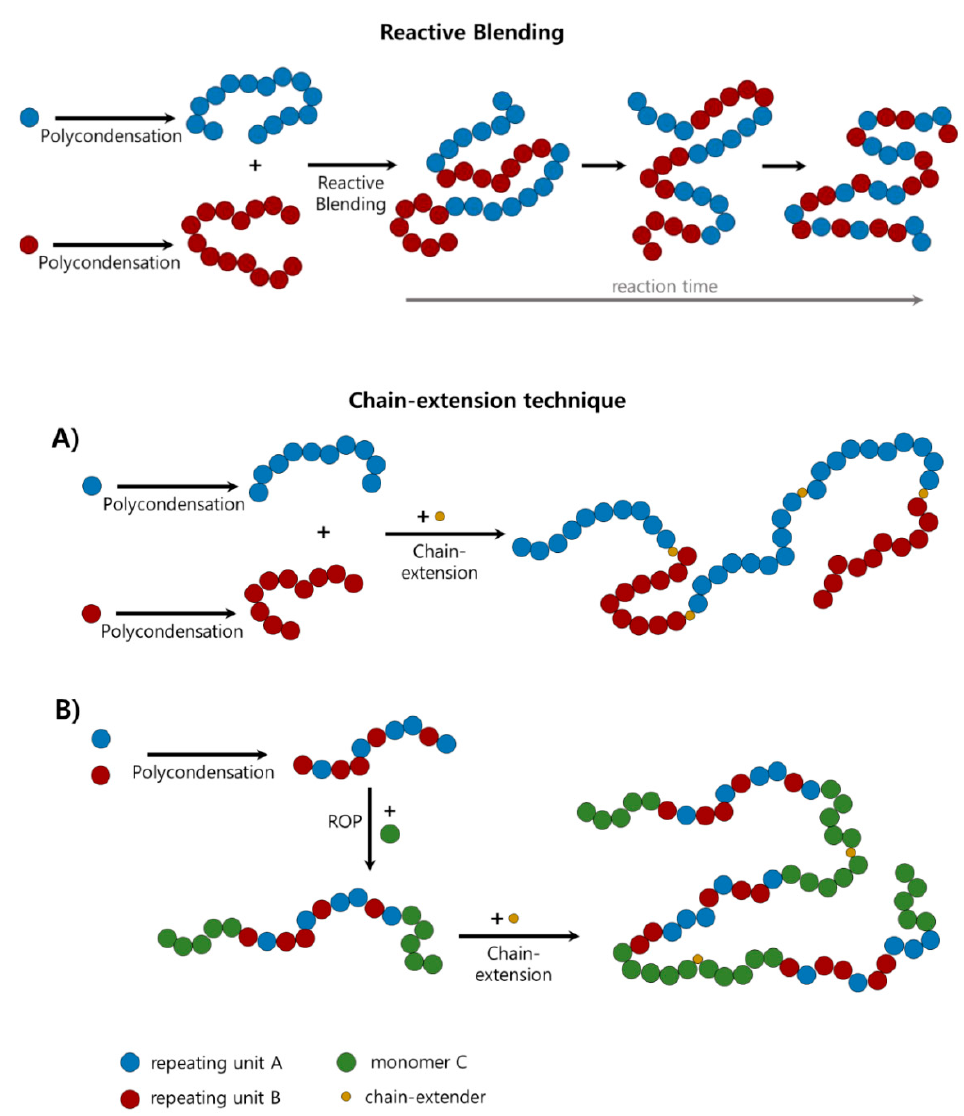
Figure 2. Copolymerization strategies. Evolution of the molecular architecture as a function of the mixing time during reactive blending (above); chain extension reactions (below): ( A ) coupling of two OH-terminated prepolymers for the preparation of random multiblock copolymers and ( B ) polycondensation of a OH-terminated (co)polymer followed by ring-opening polymerization of a lactone monomer and subsequent chain-extension for the synthesis of A-B-A type multiblock copolymers.